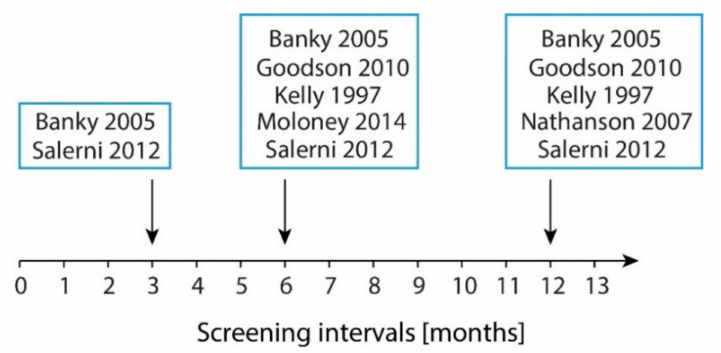
Figure 2. Imaging intervals of the prospective trials. Screening intervals according to intervals in